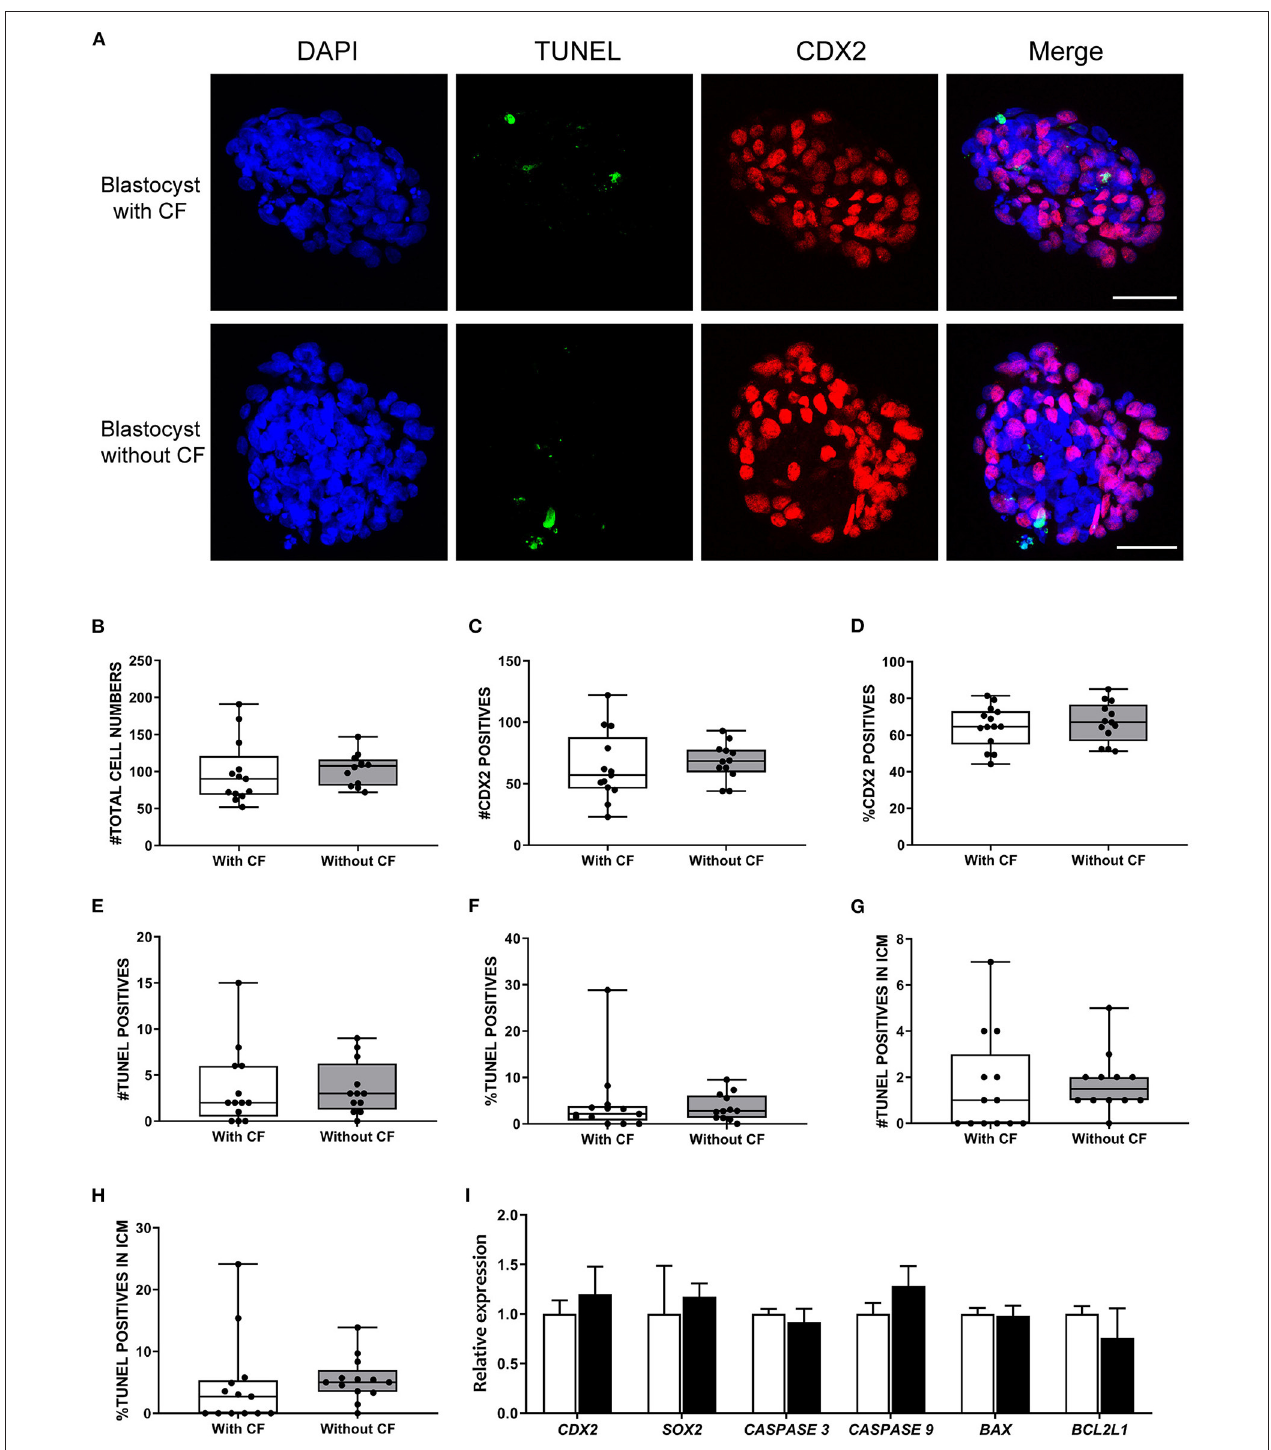
FIGURE 4 | Frequency of apoptosis and ICM to trophectoderm ratio comparison between expanded bovine blastocysts with and without cellular fragments. (A) TUNEL (green) and CDX2 (red) immunofluorescence of day 8 blastocysts with and without cellular fragments. Scale bar = 50 µ m. Box-whisker plots of total cell number (B) , CDX2 positive cells (C) , percentage of CDX2 positive cells (D) , total TUNEL positive cell number (E) , percentage of TUNEL positive cells (F) , TUNEL positive cell number in inner cell mass (ICM) (G) , percentage of TUNEL positive cell number in ICM (H) in blastocysts with cellular fragments (white, n = 64) or in blastocyst without (gray, n = 66) fragmented cells in the perivitelline space. (I) Relative expression of genes in day 8 blastocysts with (white bars) or without (black bars) fragmented cells, as determined by qRT-PCR. Error bars indicate standard deviation of three biological replicates. BL, blastocyst; CF, cellular fragmentation.